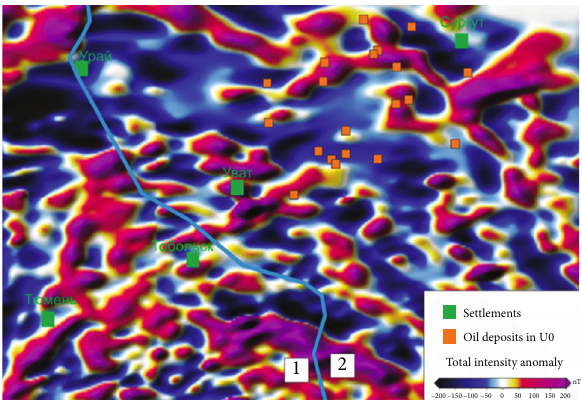
Figure 7: Magnetic anomalies and oil deposits in the Bazhenov suite: (1) no-prospect oil-bearing zone and (2) potentially productive oil-bearing zone